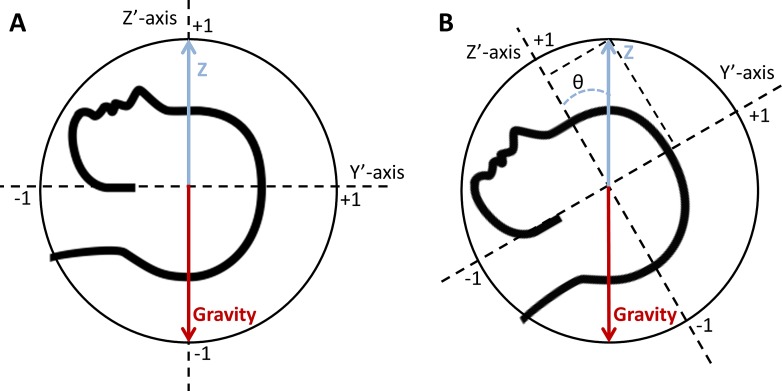
Schematic drawing of the position of the unit Z-vector (blue arrow) and gravity vector (red arrow) within the IMU coordinate system. When the patient is positioned supine with the IMU fixed on the forehead, the world Z-axis is aligned with the IMU Z′-axis (situation A). The coordinates of the unit Z-vector (blue arrow) on the IMU X′-, Y′- and Z′-axis will be 0, 0, and 1, respectively, in situation A. In situation B, a 30° rotation (θ) around the world X-axis has resulted in a 30° tilt of the IMU Y′- and Z′-axis and in a change of the coordinates of the unit Z-vector on the Y′-axis (this will be sin[θ]) and Z′-axis (cos [θ]). Rotation around the world Z-axis in either situation A or B will not change the coordinates of the unit Z-vector.